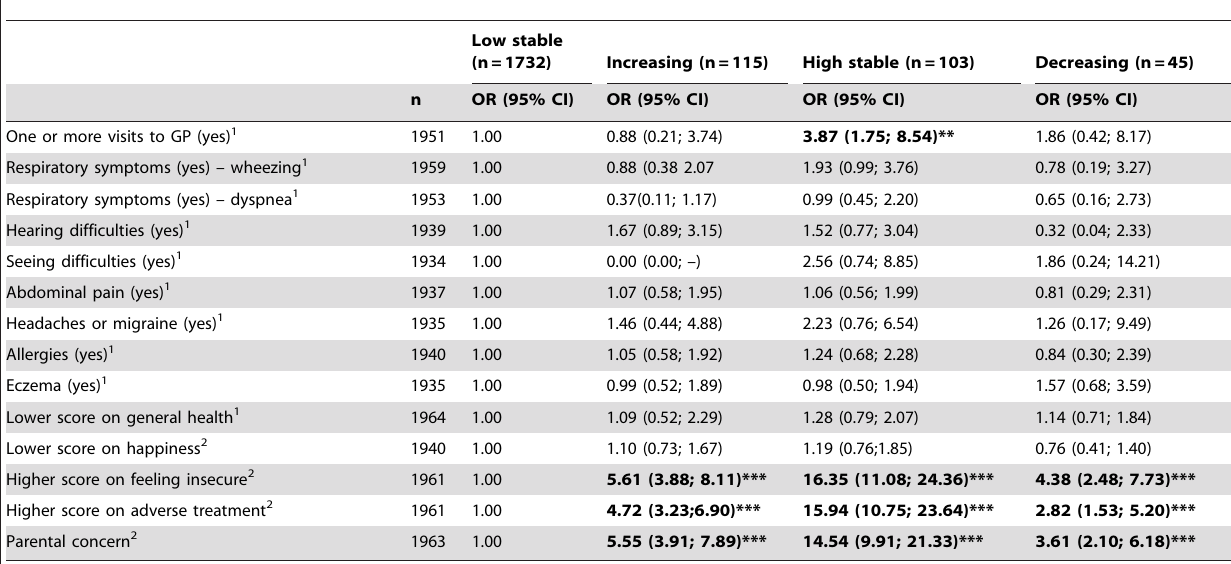
Table 4. Health outcomes at age 7 years, predicted by weight trajectory between the age of 5 and 7 years.